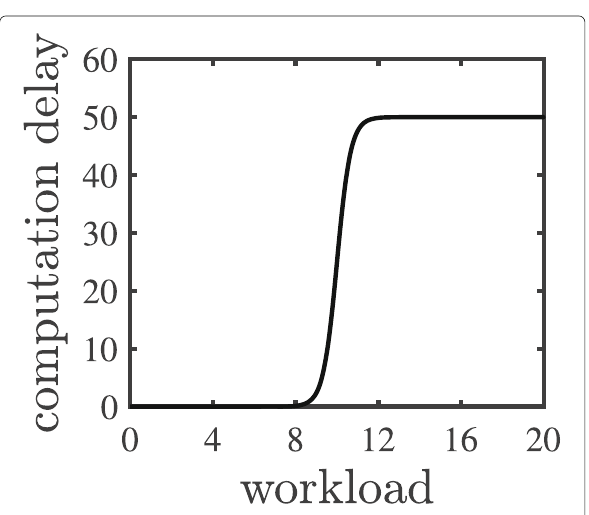
Fig. 4 An instance of the computation delay function g ( x ) , where g max =